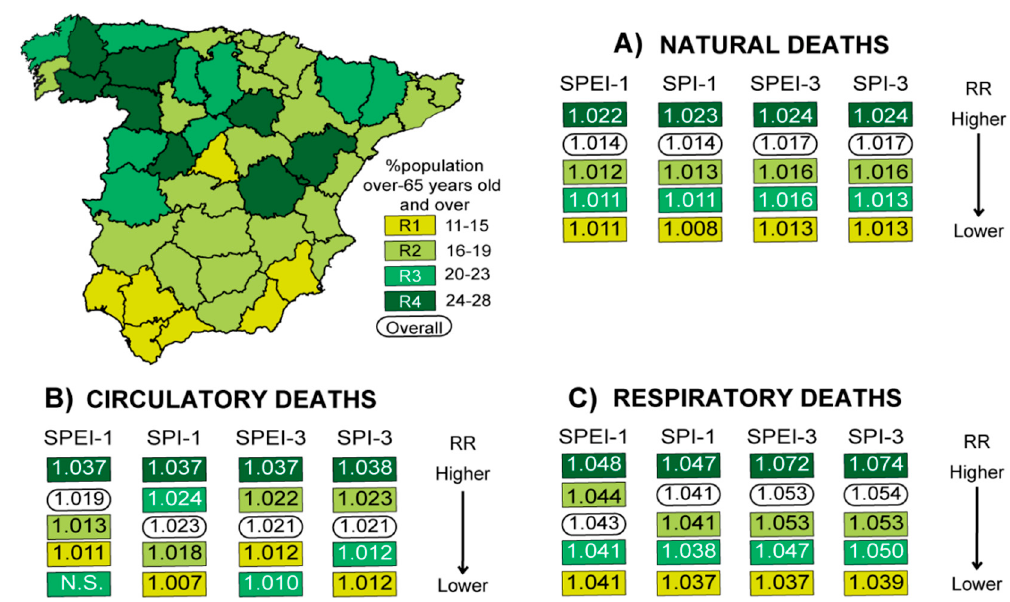
Figure 5. Combined provincial relative risk (RR) values of daily specific-cause mortality associated with drought in different territories based on the proportion of people aged 65 years and over from 2000 to 2009, measured by the Standardized Precipitation Evapotranspiration Index (SPEI) and the Standardized Precipitation Index (SPI) obtained for short and short–medium timescales (one and three months of accumulation, respectively). Complete statistical information is provided in the Supplementary Material (Figures S7–S9).